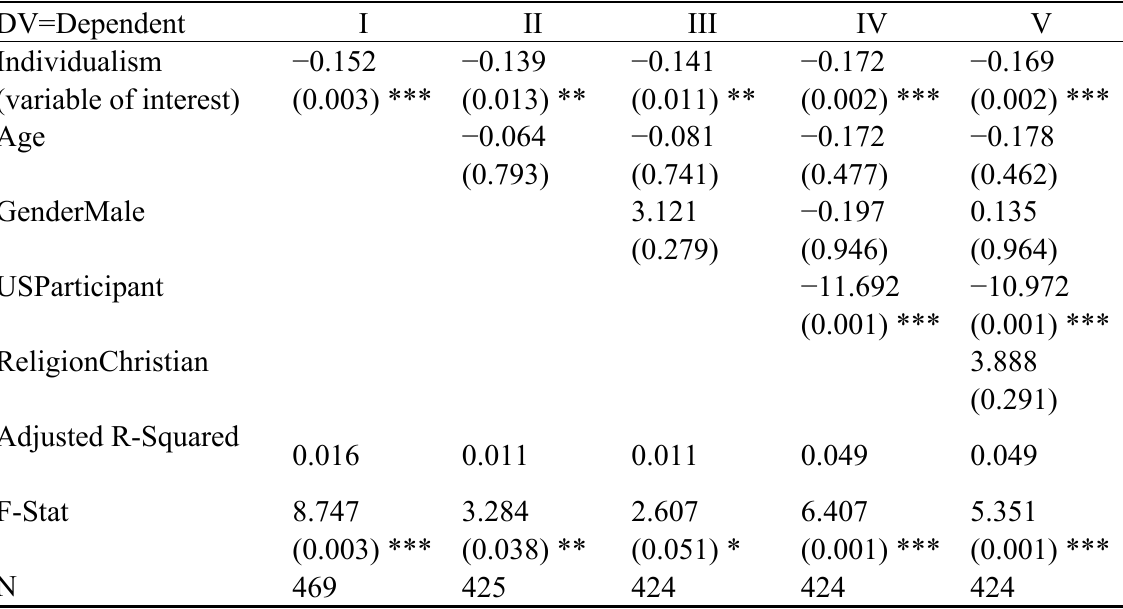
Table 2. OLS Regression Results for Dependent Decision-Making